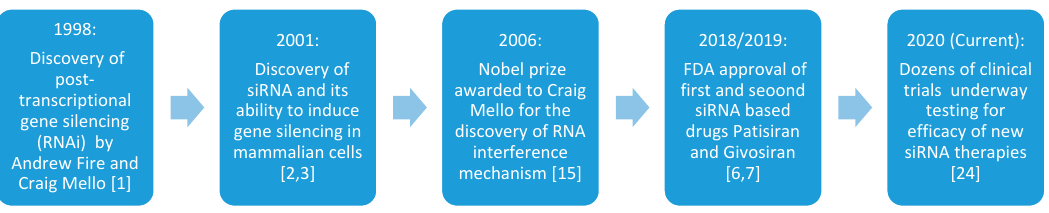
Figure 1. Timeline highlighting the major historical events leading up to siRNA therapeutics.